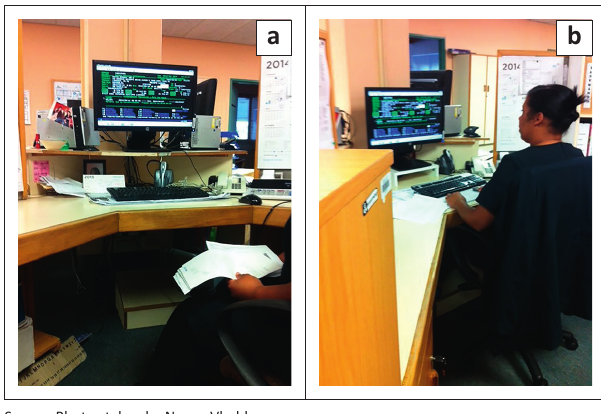
FIGURE 4: Photographs of the subject’s workstation: (a) Before workstation adjustment; (b) after workstation